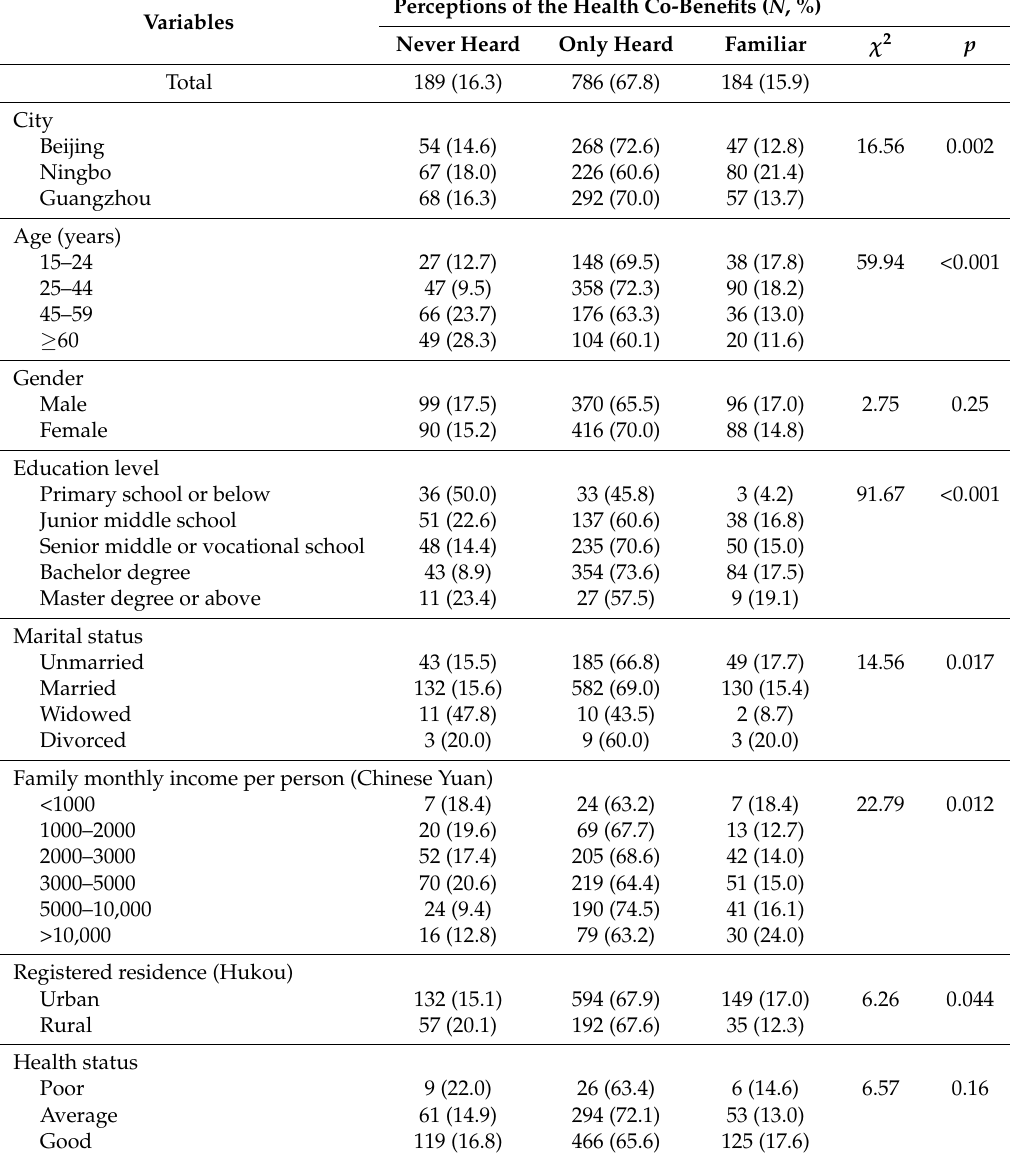
Table 3. Perceptions of respondents (by total and subgroups) on the health co-benefits of GHG emission